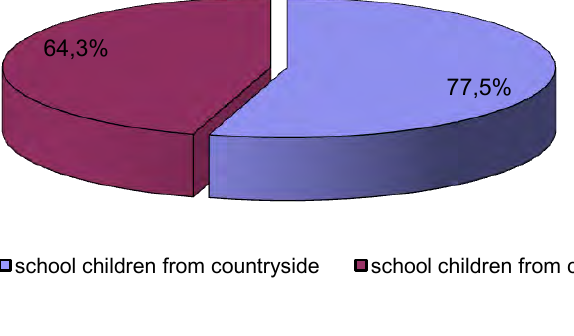
Fig. 9. Indication of schoolchildren’s involvement in